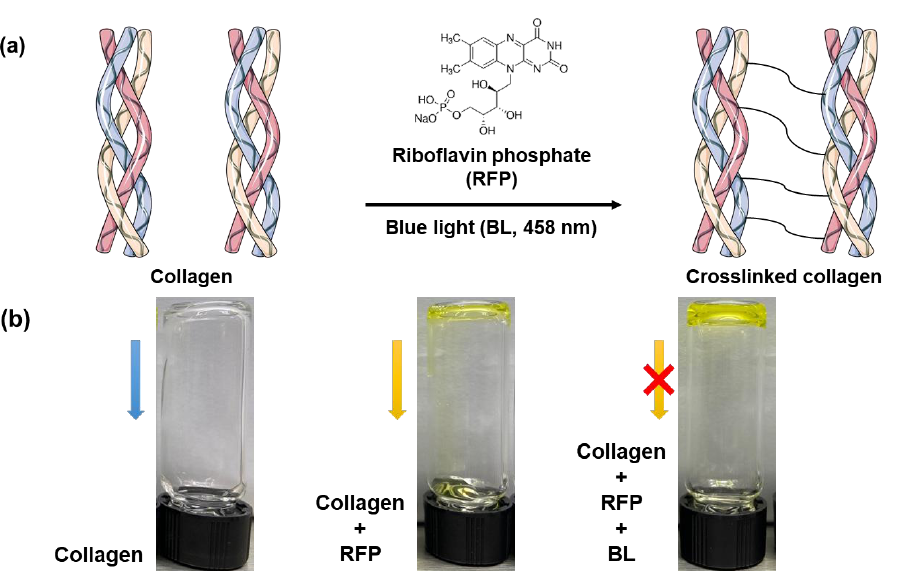
Figure 1. ( a ) Schematics of collagen crosslinking through blue light (BL)-activated riboflavin phos- phate (RFP). ( b ) Photo images of collagen solution without RFP and collagen solutions with RFP before and after BL irradiation.